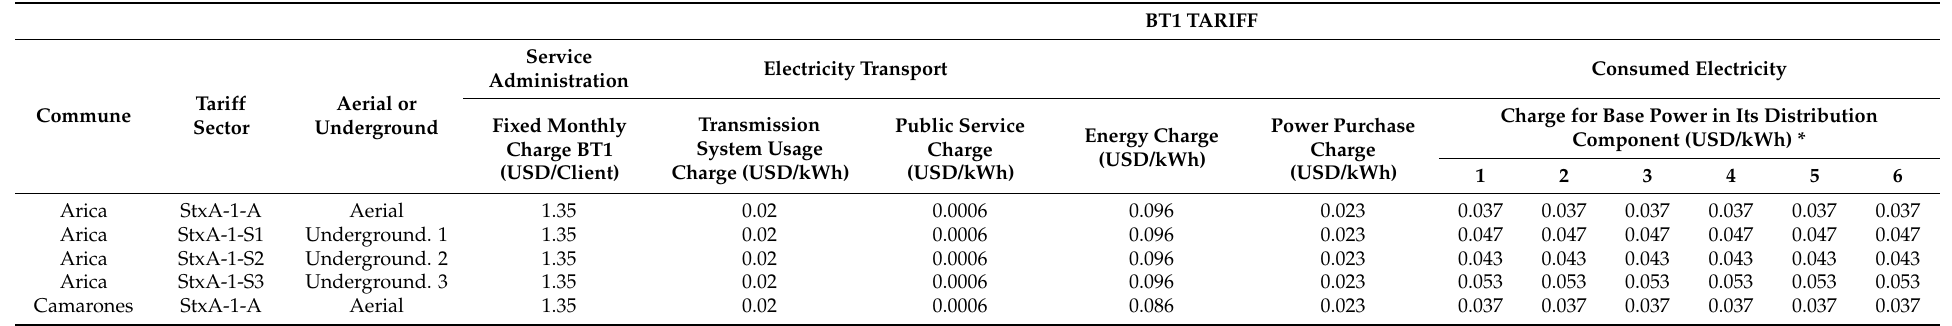
Table 3. BT1 tariff, consumed by residential customers, Source CGE, 2021